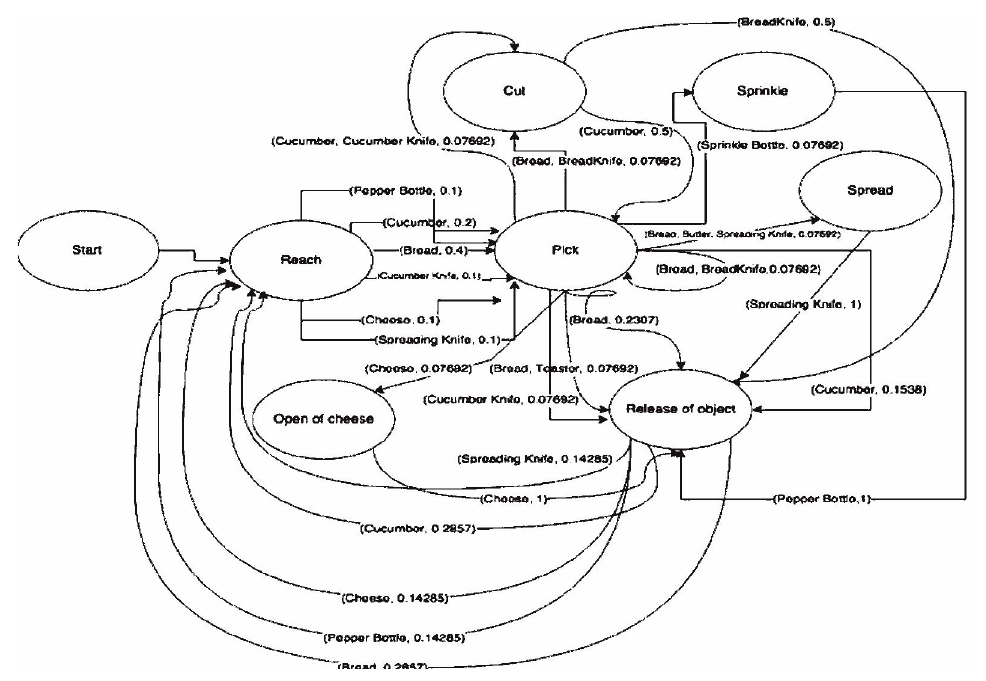
FIG. 3. STATE TRANSITION DIAGRAM FOR ACTIVITIES OF SANDWICH MAKING SCENARIO WITH OBJECT